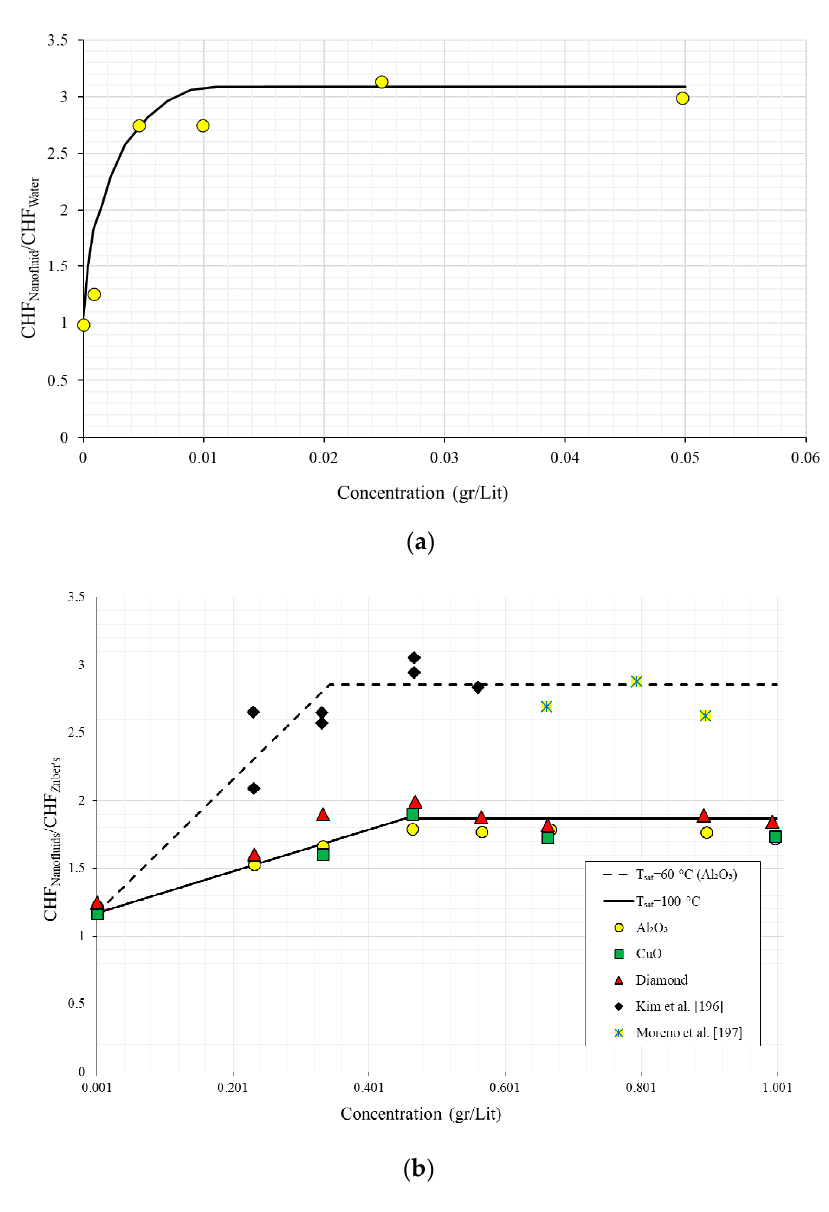
Figure 10. Influence of nanofluid concentration on CHF amelioration ( a ) from You et al. [97] and ( b ) from Kwark et al. [106] compared to [196,197]. Adapted from Mori and Utaka. Reproduced from [68], Elsevier: 2017.